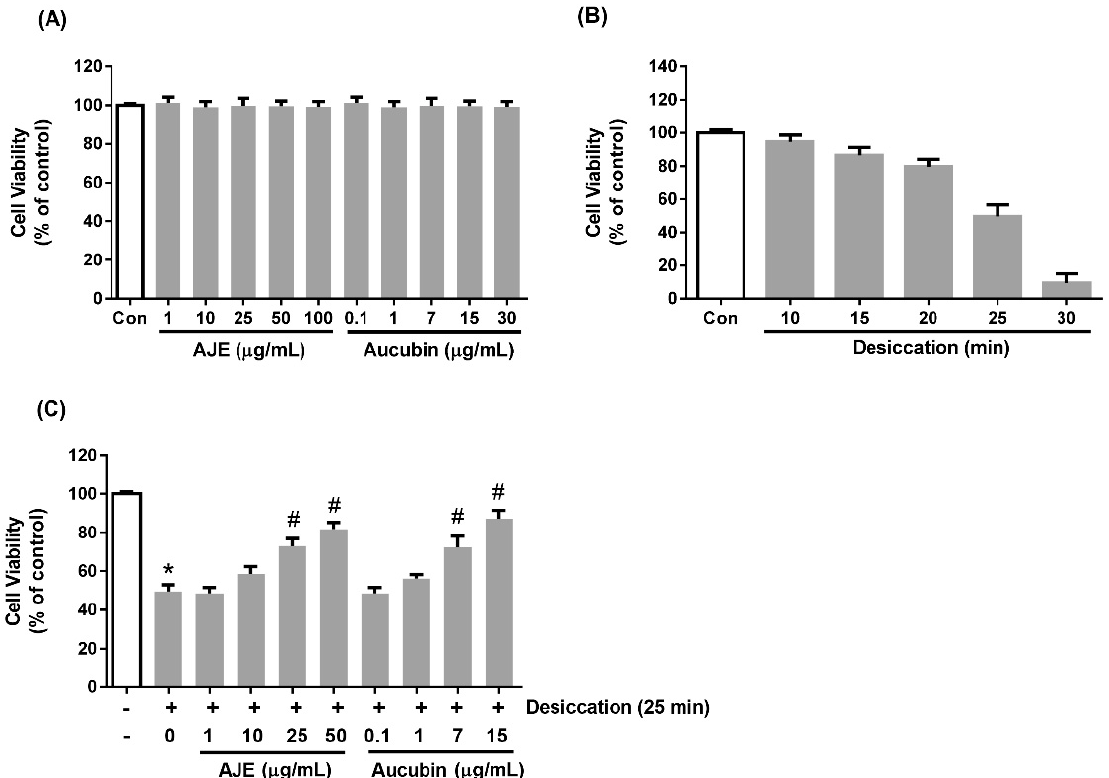
Figure 2. Effects of Aucuba japonica (AJE) and aucubin on the viability of human corneal epithelial cell. ( A ) The cell viability in the dose-dependent treatments of AJE and aucubin for 24 h. ( B ) The cell viability under the time-dependent desiccation. ( C ) The cells were pre-incubated with various concentrations of AJE and aucubin for 24 h and then exposed to air to induce desiccation stress. All of the viability is shown as % of control. The values in bar graph represent the mean ± SE. * p < 0.05 vs. control cell, # p < 0.05 vs. vehicle treated cell.